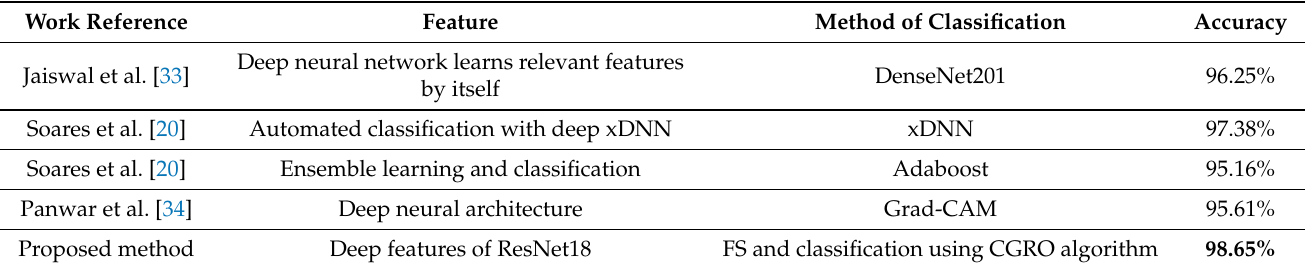
Table 11. Performance comparison of our proposed approach with some existing works for SARS-Cov-2 CT-Scan dataset. Maximum value is